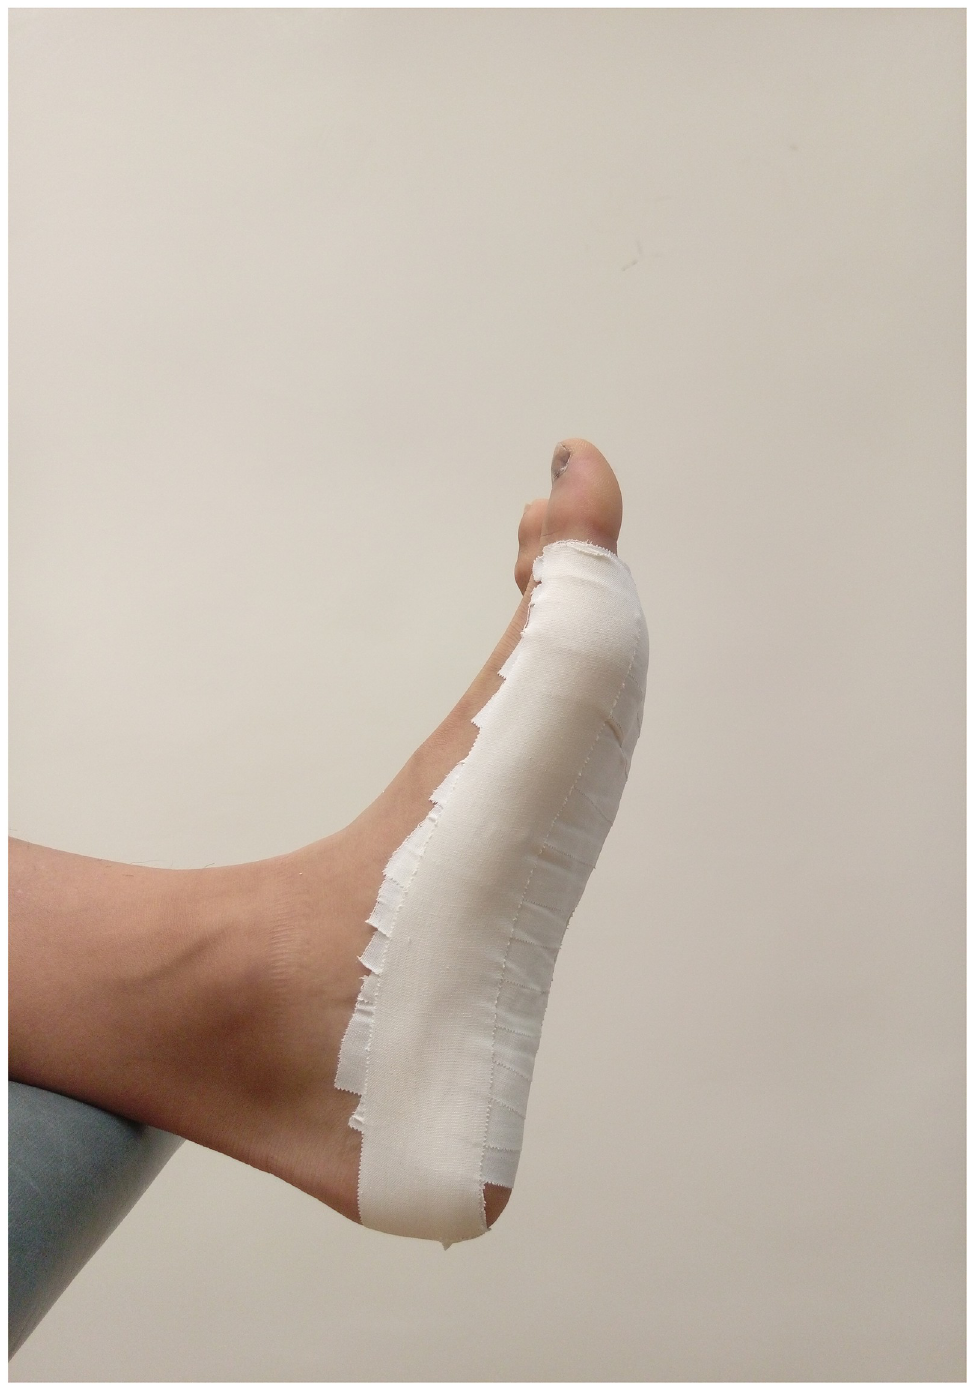
Fig 2. The LD taping